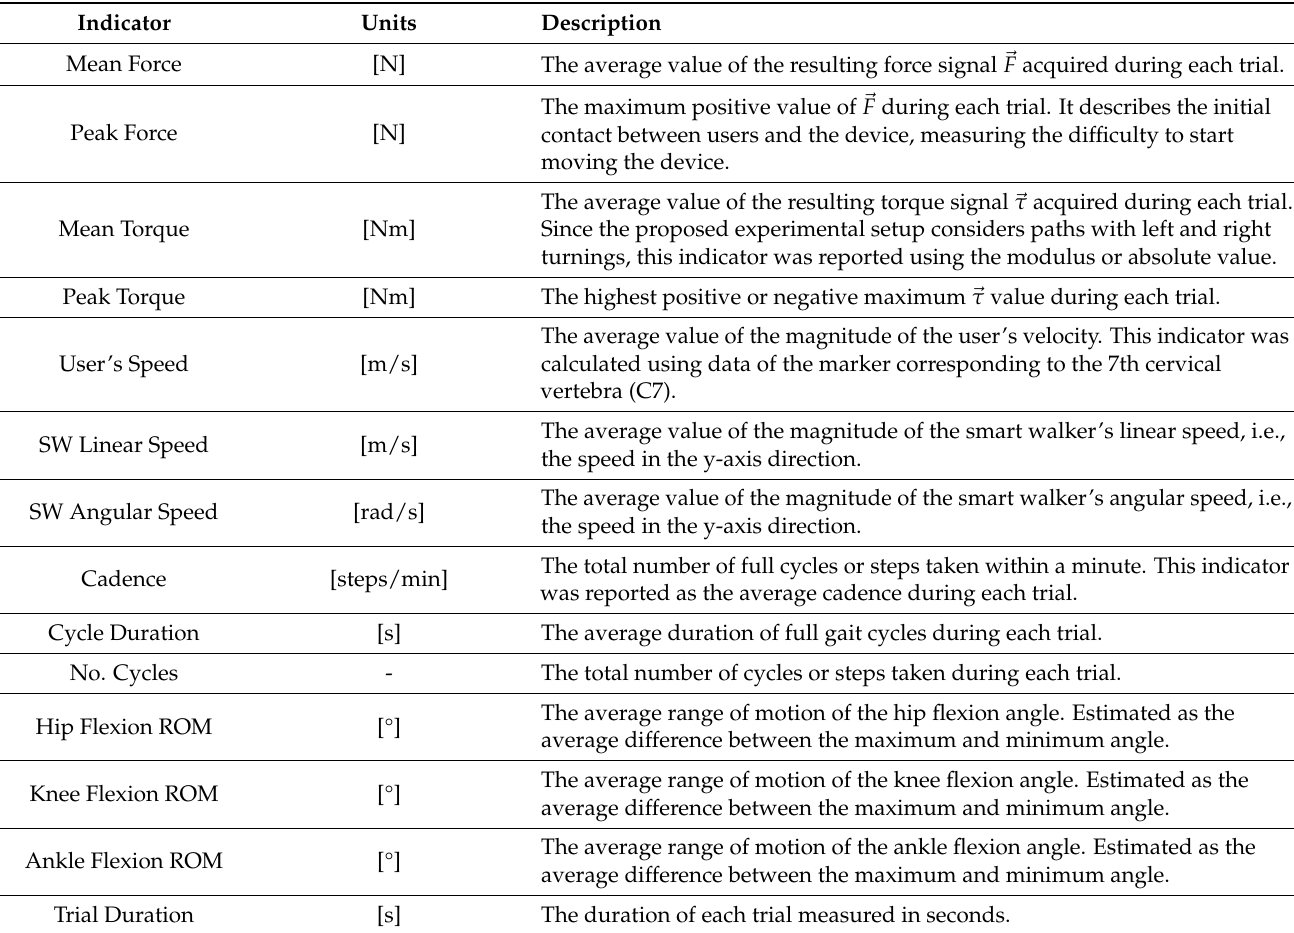
Table 2. Description and units for the outcome measures proposed to measure the performance, physical interaction, and users’ kinematics during